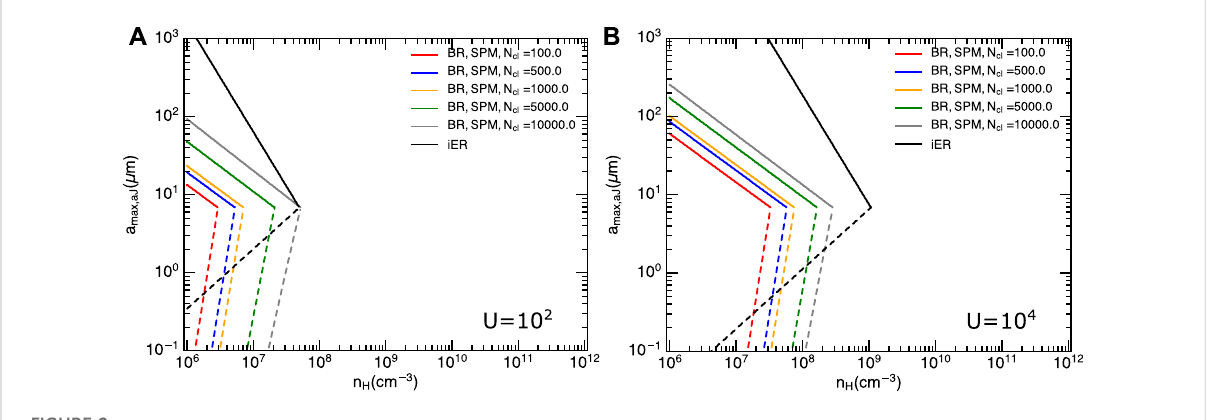
FIGURE 2 Comparison of minimum (dashed line) and maximum (solid line) size of grains having internal alignment by Barnett relaxation (BR) for superparamagneticgrain(SPM,colorlines)andinelasticmechanism(iER,blacklines)withrespecttoalargerangeofgasdensity( fi gureadoptedfrom Hoang T. et al., 2022). The grains are spun-up by RATs with U = 10 2 (A) and U = 10 4 (B)